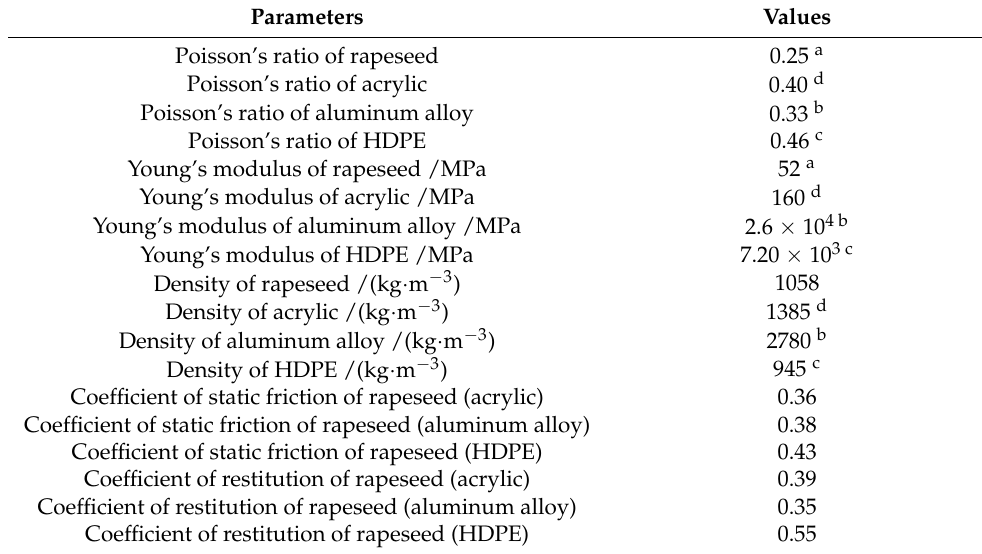
Table 4. Discrete element method (DEM) parameters for the simulations.